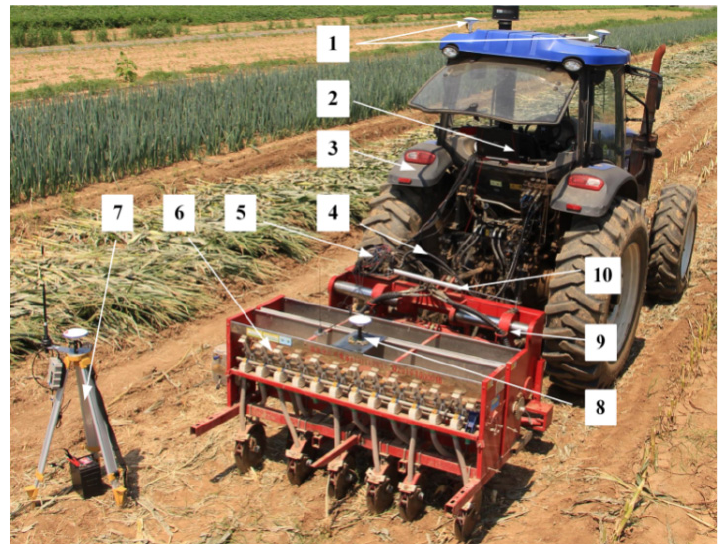
Figure 1. The overall structure of the side-shift stubble avoidance system. Note: 1, Tractor positioning antenna; 2, Train-borne computer; 3, Tractor; 4, Hydraulic system; 5, Controller; 6, Wheat no-till seeder; 7, Base station; 8, Implement positioning antenna; 9, Side-shift mechanism; 10, Displacement sensor.